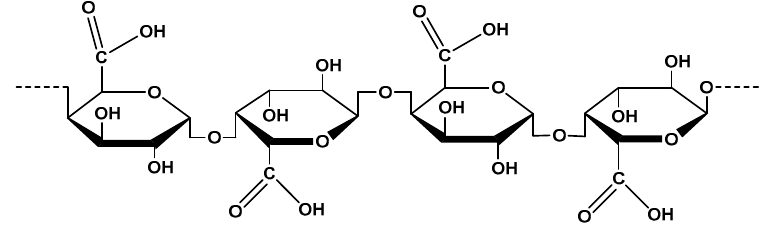
Figure 1. Structure of α -(1,4)- d -polygalacturonic acid (PGA). Table 1. Galacturonic acid and neutral sugars contents (mg / g) of some acid extracted pectins.